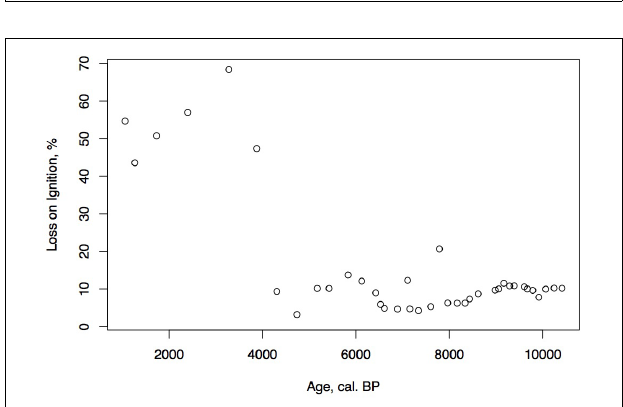
FIGURE 3 | Holocene age-depth plot and LOI for the Phalarope Pond